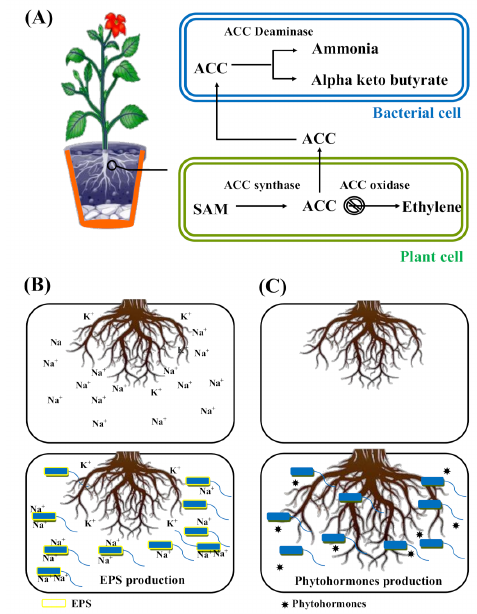
Figure 2. Bacterial metabolite mediated mechanism for minimizing salt stress in order to boost plant growth and development. ( A ) The ACC deaminase enzyme, ( B ) EPS production, and ( C ) Phyto- hormones production. SAM (S-adenosyl-L-methionine); ACC (1-Aminocyclopropane-1-Carboxylic Acid); EPS (Extracellular Polymeric Substances). Top plane of ( B , C ) are without bacterial cell and bottom plane is with bacterial